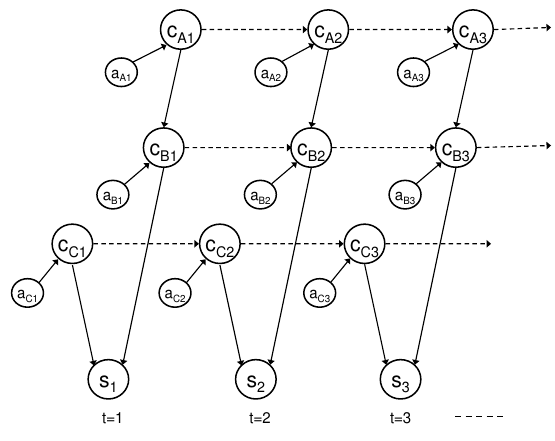
Fig. 1. DBN representation with action nodes.